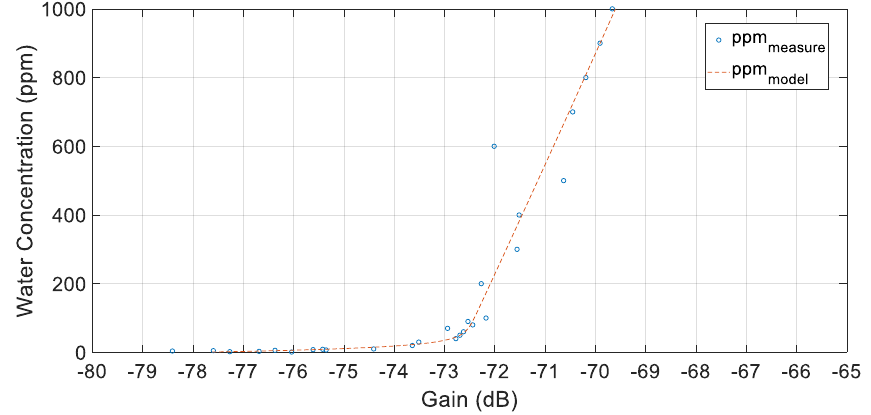
Figure 18. Measures of the minimum value of gain in the range of 3 MHz up to 4 MHz and the fitted curve.